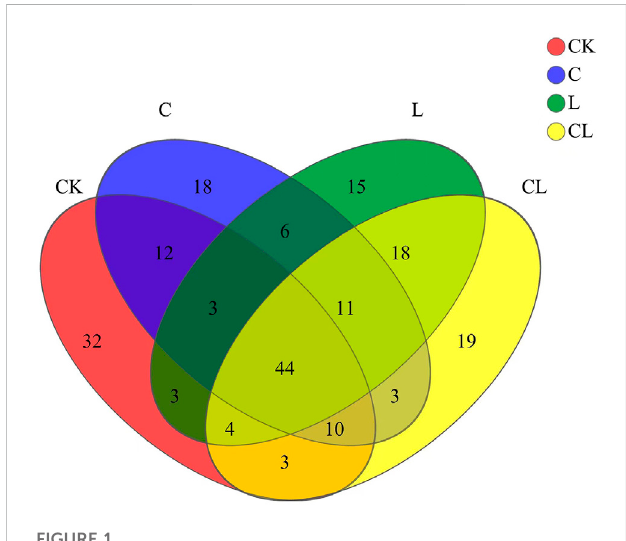
FIGURE 1 Operational taxonomic unit distribution Venn diagram.